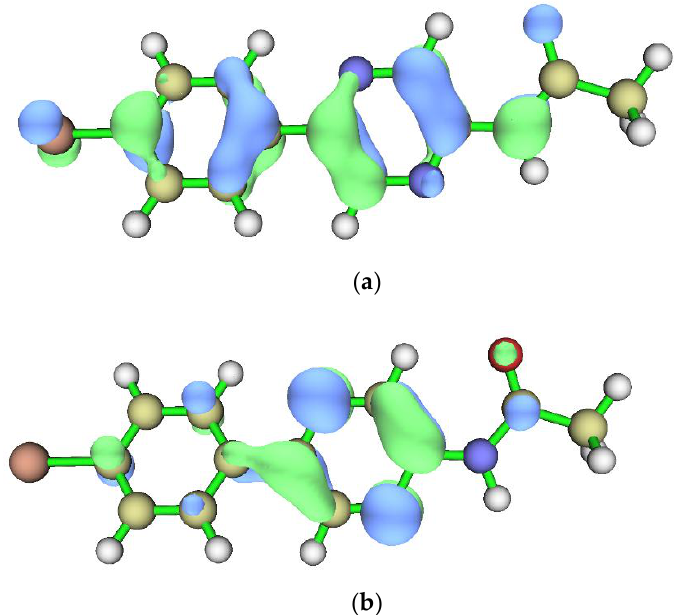
Figure 7. HOMO ( a ) and LUMO ( b ) orbitals for Br-Clmd-2 in implicit water, when calculated at the TD-PBE0 level of